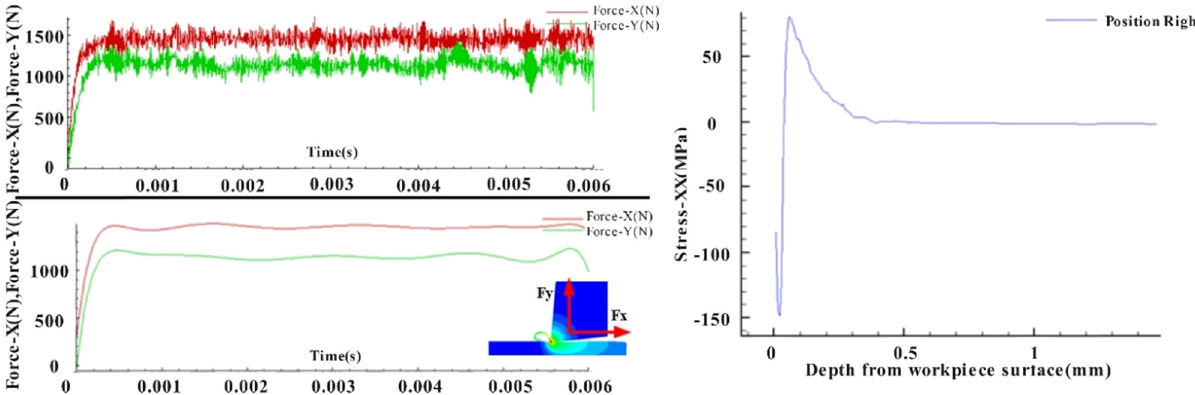
Figure 4: The simulation of cutting force and residual